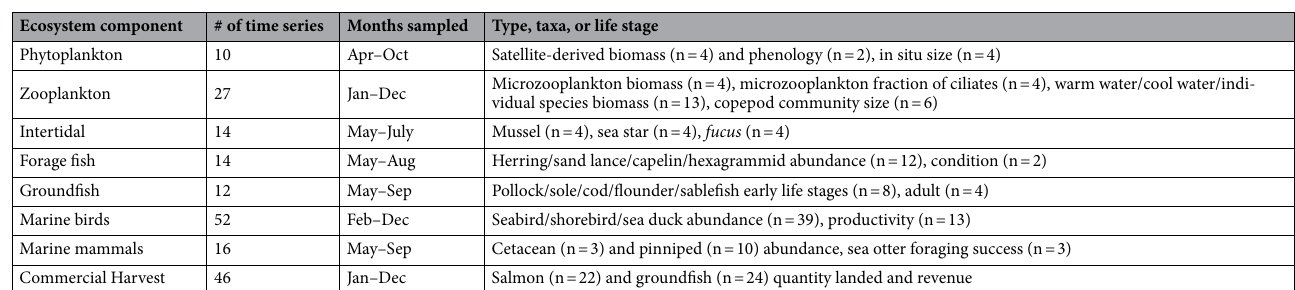
Table 1. Type, number, and months sampled of biological time series (n = 187 total) used to assess response to a marine heatwave in the Gulf of Alaska. Sources of time series include the Exxon Valdez Oil Spill